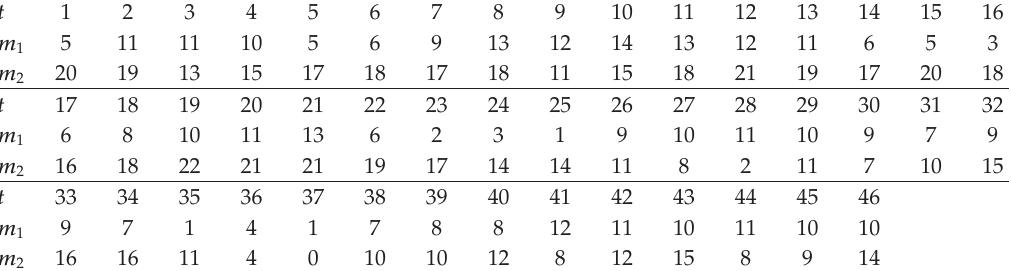
Table 1: The theoretical block sizes for the forecast horizons 1 to 46